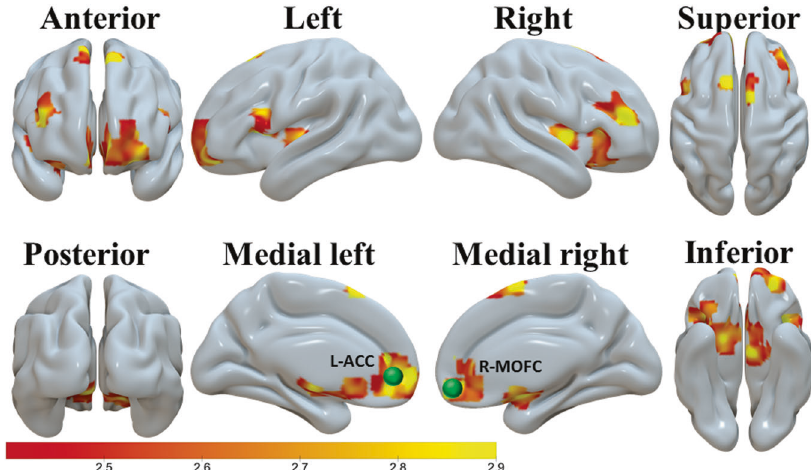
Fig. 2 The brain activation used to constrain the a priori-selected L-ACC (in medial left view) and R-MOFC (in medial right view) DCM node is depicted using the Surf Ice software (https://www.nitrc.org/plugins/mwiki/index.php/sur fi ce:MainPage, posted by Dr. Chris Rorden). The brain activation clusters shown were identi fi ed by a SPM second level one-sample t -test analysis for the placebo scan and for all participants (CW minus NW > 0), with cluster-de fi ning threshold t = 2.4 and uncorrected two-tailed cluster level p < 0.05. Scale on the color bar represents voxel t values. The nodes (spheres) are larger than the exact ones for demonstration purpose.